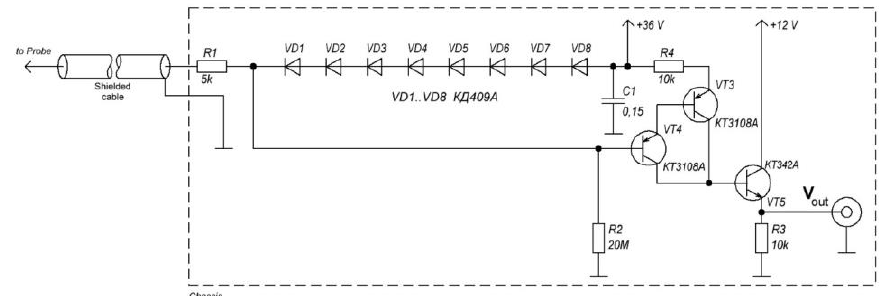
Figure 7. Electrical circuit of the active logarithmic ion sensor.